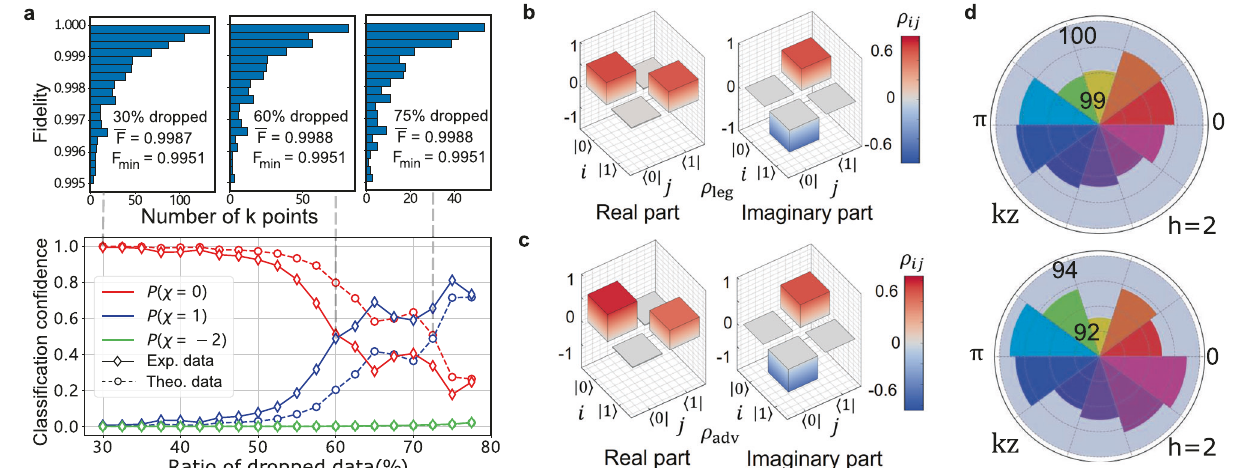
Fig. 2 | Experimentally implemented adversarial examples. a The classi fi cation con fi dence for experimental (Exp.) and theoretical (Theo.) data at h =3.2 with differ- ent dropping ratios. For theoretical (experimental) data, the classi fi er gives correct predictionswith75%(60%)ofthedatasamplesdropped.Thepanelsintheupperrow showthe fi delitydistributionoftheremainingdatawhenthedroppingratiosare30%, 60%, and 75%, respectively. The average fi delity (cid:2) F and minimum fi delity F min remain almostunchangedatdifferentdroppingratios. b Densitymatrixoftheexperimentally implemented legitimate sample ρ leg at k =(0.2 π ,0.6 π ,1.4 π ) and h =0.5, with fi delity